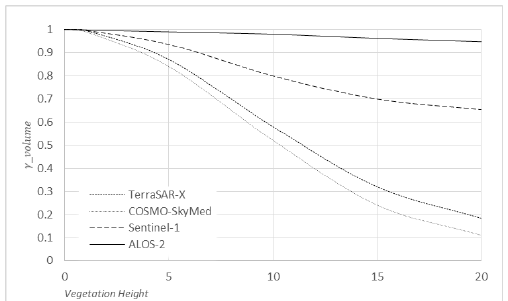
Figure 3 The relationship between volume scattering decorrelation and vegetation height (under different sensor parameters)